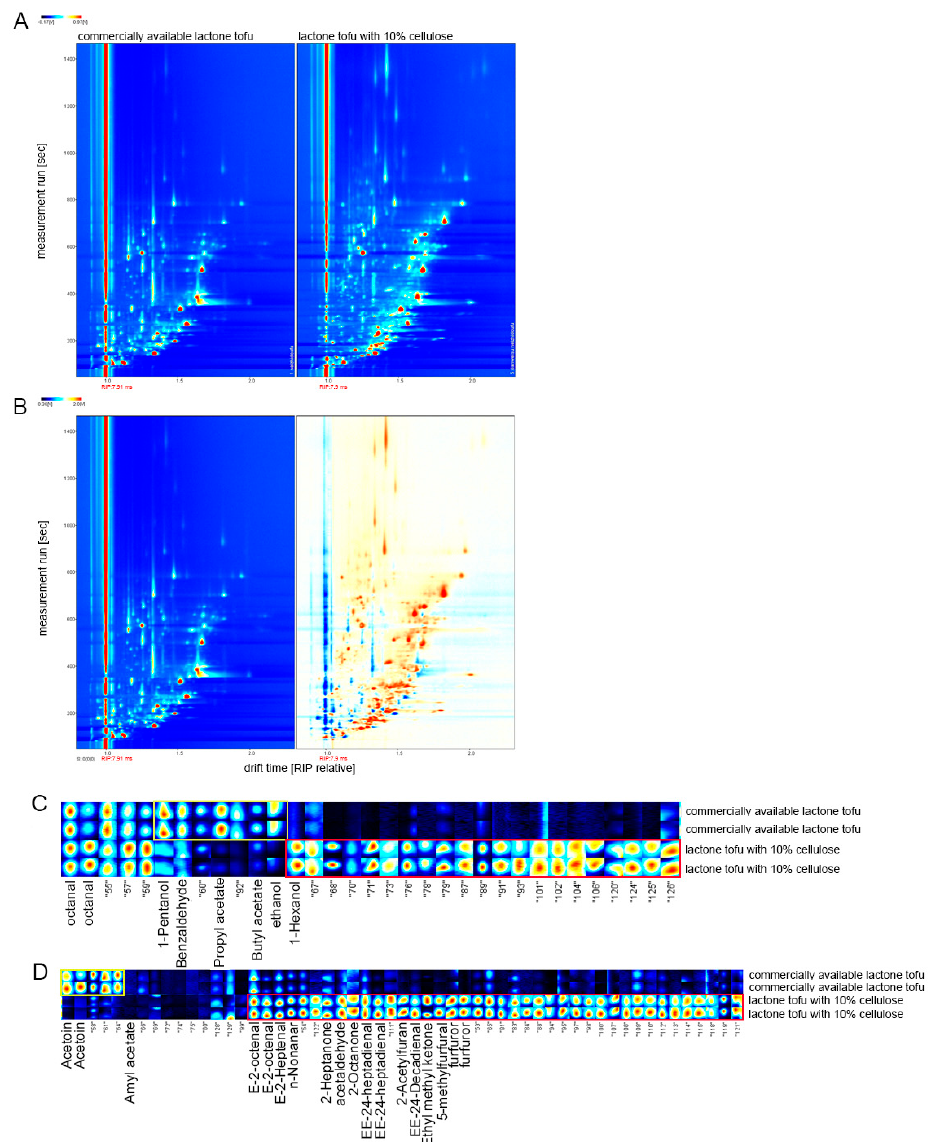
Figure 7. Analysis of the volatile components of the different tofu types. ( A , B ) The ordinate represents the retention time of the gas chromatograph, and the abscissa represents the ion migration time. The background of the whole picture is blue, and the red vertical line at 1.0 is the RIP peak (reactive ion peak, normalized). Each point on either side of the RIP peak represents a volatile organic compound. The color represents the concentration of the substance: white indicates a lower concentration, red indicates a higher concentration, and darker color indicates a higher concentration. ( C , D ) Each row in the graph represents all signal peaks selected in the tofu sample. Each column in the figure represents the signal peak of the same volatile organic compound in the different tofu samples. The complete volatility information for each sample and the difference in volatile organic compounds between the samples can be seen in the graph.